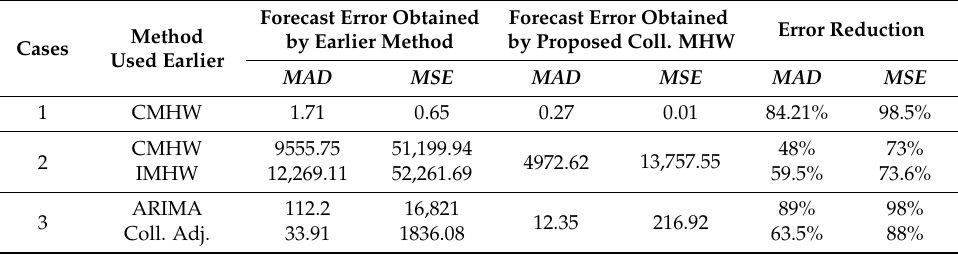
Table 6. Comparison of forecasting